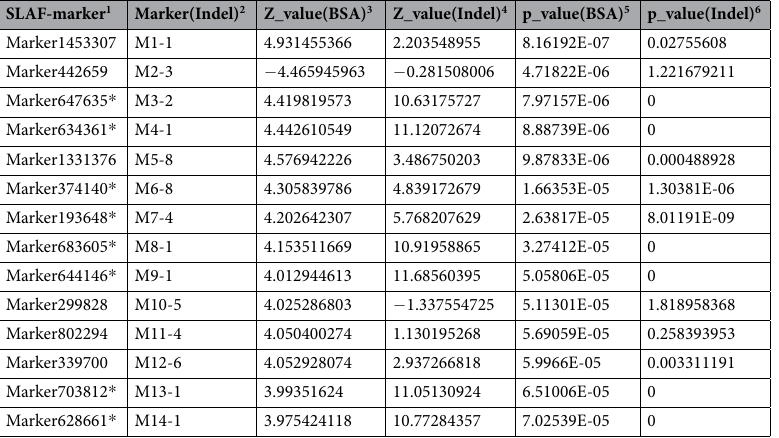
SLAF-marker 1 Marker(Indel) 2 Z_value(BSA) 3 Z_value(Indel) 4 p_value(BSA) 5 p_value(Indel) 6